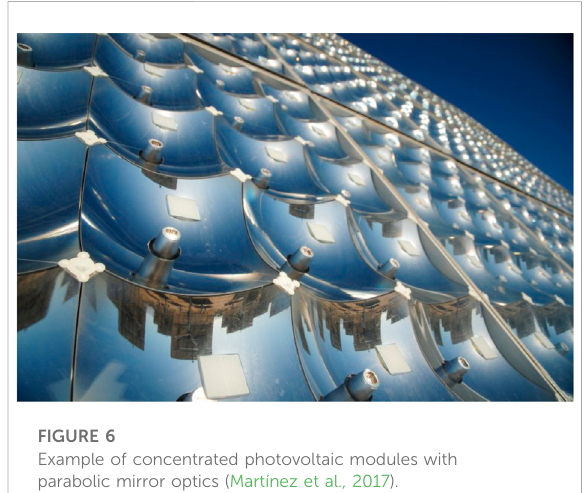
FIGURE 6 Example of concentrated photovoltaic modules with parabolic mirror optics (Martínez et al.,